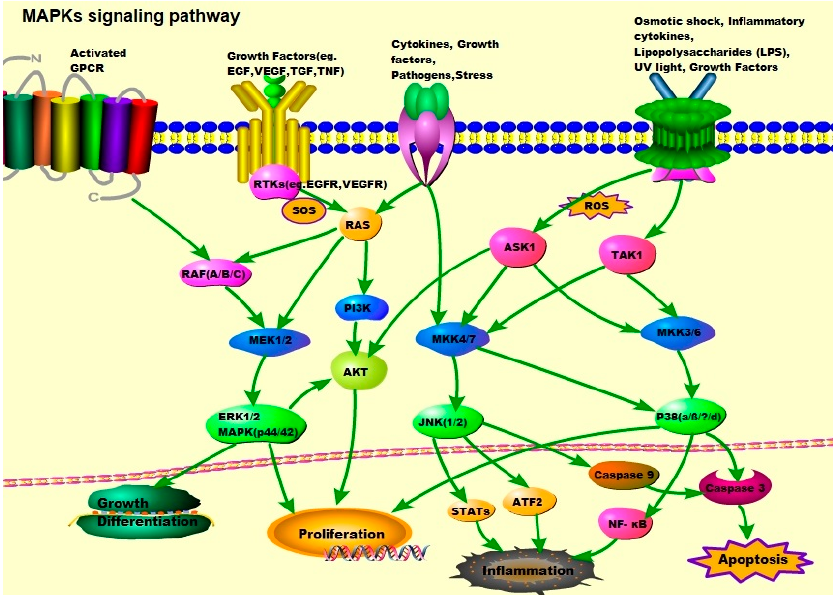
Figure 1. MAPK signaling pathway: ERK1 / 2, JNK1 / 2, and p38 . Activation of ERK begins with the phosphorylation of MEK1 / 2, followed by activation of tyrosine and threonine residues. Activated RAF binds to and phosphorylates the kinases MEK1 / 2 as well as activated RAS. The RAS activation occurs at the plasma membrane and is mediated by son of sevenless (SOS), a guanine nucleotide exchange factor (GEF). Signals from cell surface receptors are passed through RAS-GTP to the RAF(A / B / C) and / or PI3K, the latter then activates the PI3K / AKT signaling pathway. RAF also receives signals from the activated ligands’ G protein-coupled receptors (GPCRs). Activated RAF is capable of phosphorylating MEK, and subsequently, the ERK / MAPK signaling pathway. After activation of ERK, ERK1 / 2 moves to the cytoplasm and nucleus to phosphorylate other proteins. These proteins are responsible for cell regulation, growth, di ff erentiation, and mitosis. JNK is activated in response to cytokines, growth factors, pathogens, stress, etc., and is associated with the transformation of oncogenes and growth factor pathways. Activation of JNK requires dual phosphorylation tyrosine and threonine, the MAP2Ks that catalyze this reaction are known as MKK4 (also known as SEK1) and MKK7. MKK4 / 7 are phosphorylated and activated by MAP3Ks, TAK1, and ASK1. Tumor necrosis factor (TNF) receptor signaling and ROS might be the major upstream mediators of JNK activation. Abnormal activation of the JNK signaling pathway is linked to the development of cancer, diabetes, inflammatory diseases, and neurodegenerative diseases. The activation of p38 is mediated by upstream kinases, MAP kinase 3 (MKK3), and MAP kinase 6 (MKK6). MKK3 / 6 are activated by MAP3Ks such as ASK1 and